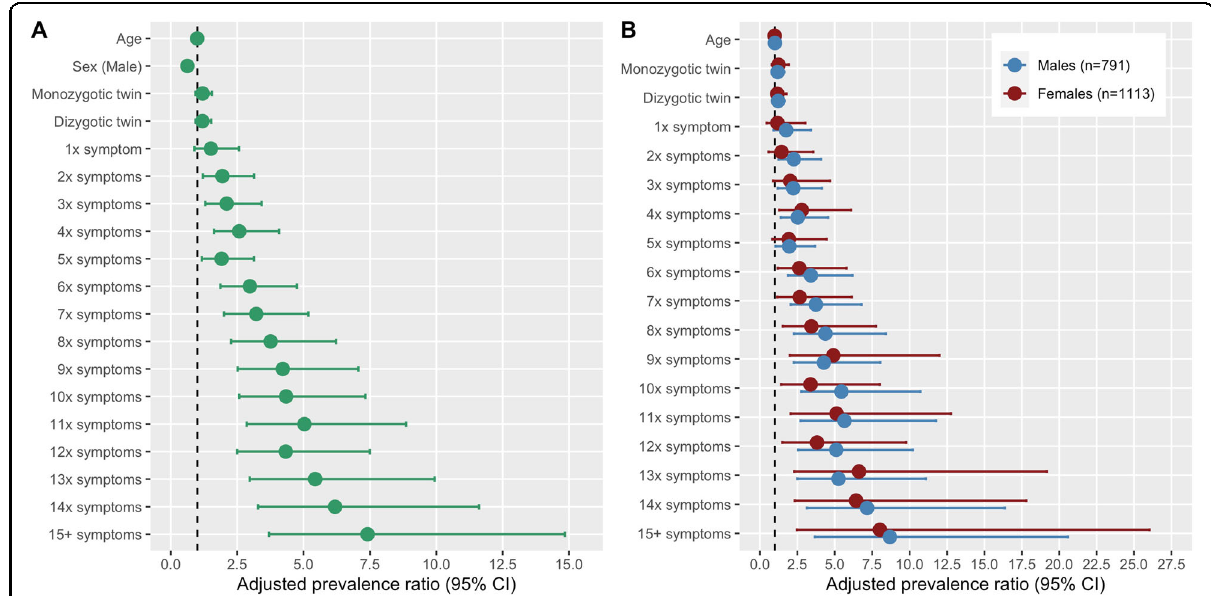
Fig. 3 Relationships between days out of role and the total number of undifferentiated symptoms in a community-based cohort of young adults. A Model for total sample. B Separate models strati fi ed by sex.